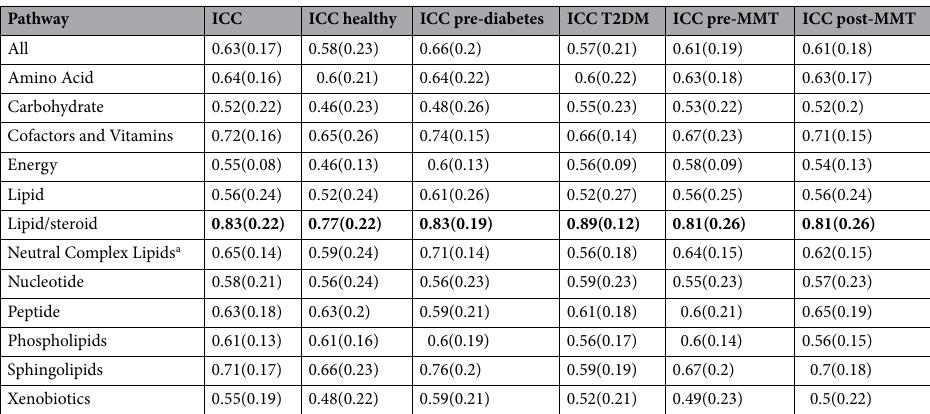
Table 3. Summary statistics for ICC by pathway. a Cholesterol esters, diacyglycerols, free fatty acids, triacylglycerols, ceramides,